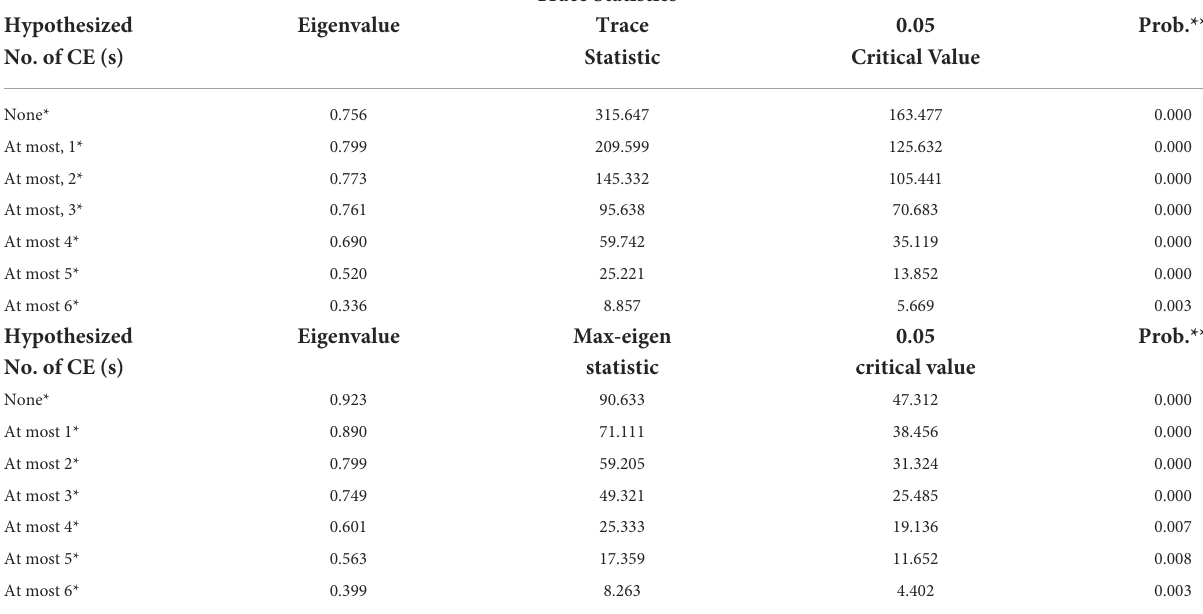
TABLE 7 Johnson co-integration